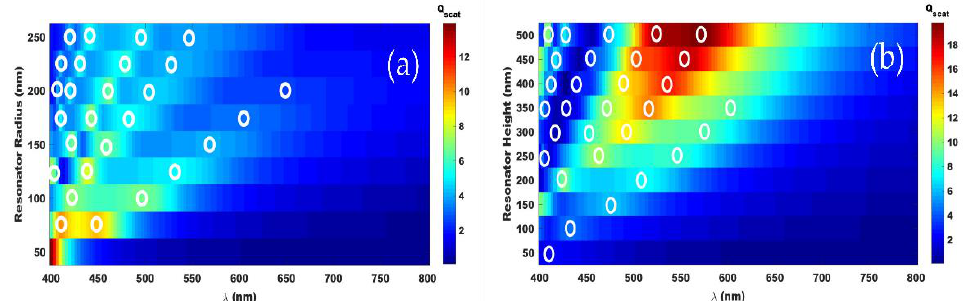
Figure 2. Normalized scattering cross-section (SCS) of a single TiO 2 resonator, placed in air, ( a ) as a function of disk radius at a constant height of 200 nm and ( b ) as a function of disk height at a constant radius of 110 nm. The SCS was normalized with the geometrical cross-section ( π r 2 ) of the disk. The white circles represent resonance peaks of ED, MD, and other higher order multipole moments.